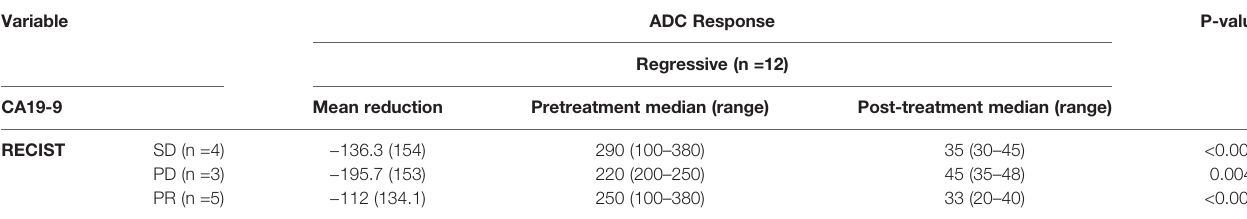
TABLE 7 | Association between RECIST and CA19-9 in ADC